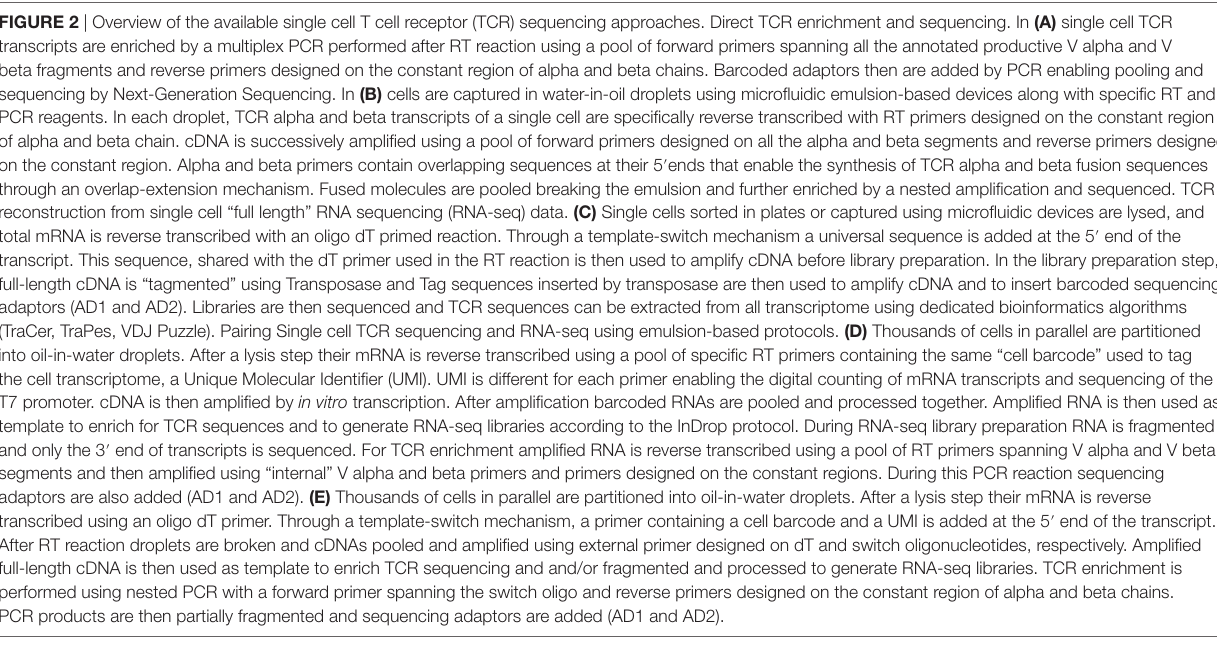
FigURe 2 | Overview of the available single cell T cell receptor (TCR) sequencing approaches. Direct TCR enrichment and sequencing. In (A) single cell TCR transcripts are enriched by a multiplex PCR performed after RT reaction using a pool of forward primers spanning all the annotated productive V alpha and V beta fragments and reverse primers designed on the constant region of alpha and beta chains. Barcoded adaptors then are added by PCR enabling pooling and sequencing by Next-Generation Sequencing. In (B) cells are captured in water-in-oil droplets using microfluidic emulsion-based devices along with specific RT and PCR reagents. In each droplet, TCR alpha and beta transcripts of a single cell are specifically reverse transcribed with RT primers designed on the constant region of alpha and beta chain. cDNA is successively amplified using a pool of forward primers designed on all the alpha and beta segments and reverse primers designed on the constant region. Alpha and beta primers contain overlapping sequences at their 5 ′ ends that enable the synthesis of TCR alpha and beta fusion sequences through an overlap-extension mechanism. Fused molecules are pooled breaking the emulsion and further enriched by a nested amplification and sequenced. TCR reconstruction from single cell “full length” RNA sequencing (RNA-seq) data. (C) Single cells sorted in plates or captured using microfluidic devices are lysed, and total mRNA is reverse transcribed with an oligo dT primed reaction. Through a template-switch mechanism a universal sequence is added at the 5 ′ end of the transcript. This sequence, shared with the dT primer used in the RT reaction is then used to amplify cDNA before library preparation. In the library preparation step, full-length cDNA is “tagmented” using Transposase and Tag sequences inserted by transposase are then used to amplify cDNA and to insert barcoded sequencing adaptors (AD1 and AD2). Libraries are then sequenced and TCR sequences can be extracted from all transcriptome using dedicated bioinformatics algorithms (TraCer, TraPes, VDJ Puzzle). Pairing Single cell TCR sequencing and RNA-seq using emulsion-based protocols. (D) Thousands of cells in parallel are partitioned into oil-in-water droplets. After a lysis step their mRNA is reverse transcribed using a pool of specific RT primers containing the same “cell barcode” used to tag the cell transcriptome, a Unique Molecular Identifier (UMI). UMI is different for each primer enabling the digital counting of mRNA transcripts and sequencing of the T7 promoter. cDNA is then amplified by in vitro transcription. After amplification barcoded RNAs are pooled and processed together. Amplified RNA is then used as template to enrich for TCR sequences and to generate RNA-seq libraries according to the InDrop protocol. During RNA-seq library preparation RNA is fragmented and only the 3 ′ end of transcripts is sequenced. For TCR enrichment amplified RNA is reverse transcribed using a pool of RT primers spanning V alpha and V beta segments and then amplified using “internal” V alpha and beta primers and primers designed on the constant regions. During this PCR reaction sequencing adaptors are also added (AD1 and AD2). (e) Thousands of cells in parallel are partitioned into oil-in-water droplets. After a lysis step their mRNA is reverse transcribed using an oligo dT primer. Through a template-switch mechanism, a primer containing a cell barcode and a UMI is added at the 5 ′ end of the transcript. After RT reaction droplets are broken and cDNAs pooled and amplified using external primer designed on dT and switch oligonucleotides, respectively. Amplified full-length cDNA is then used as template to enrich TCR sequencing and and/or fragmented and processed to generate RNA-seq libraries. TCR enrichment is performed using nested PCR with a forward primer spanning the switch oligo and reverse primers designed on the constant region of alpha and beta chains. PCR products are then partially fragmented and sequencing adaptors are added (AD1 and